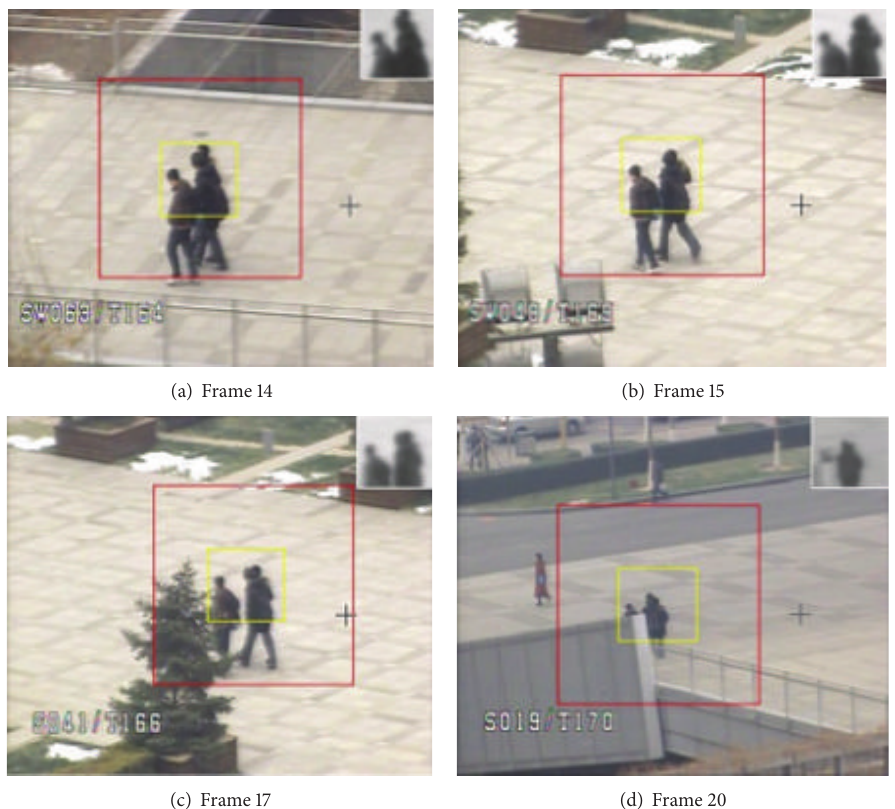
Figure 8: The tracking result of the moving objects by controlling continuously PTZ camera.